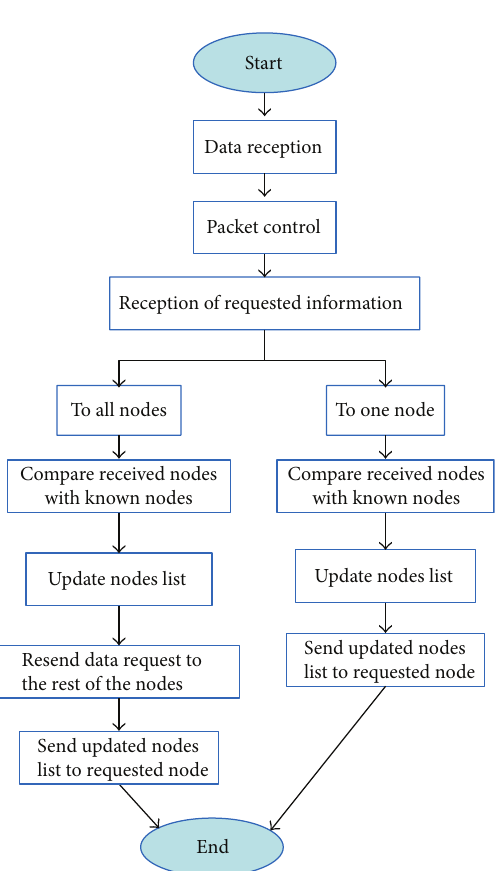
Figure 8: Procedure when information is